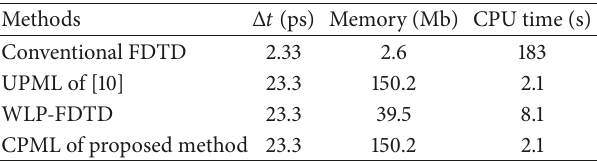
Table 1: Comparison of CPU resource for various methods. Methods Δ𝑡 (ps) Memory (Mb) CPU time (s) Conventional FDTD 2.33 183 UPML of [10] 23.3 WLP-FDTD 23.3 CPML of proposed method 23.3 150.2